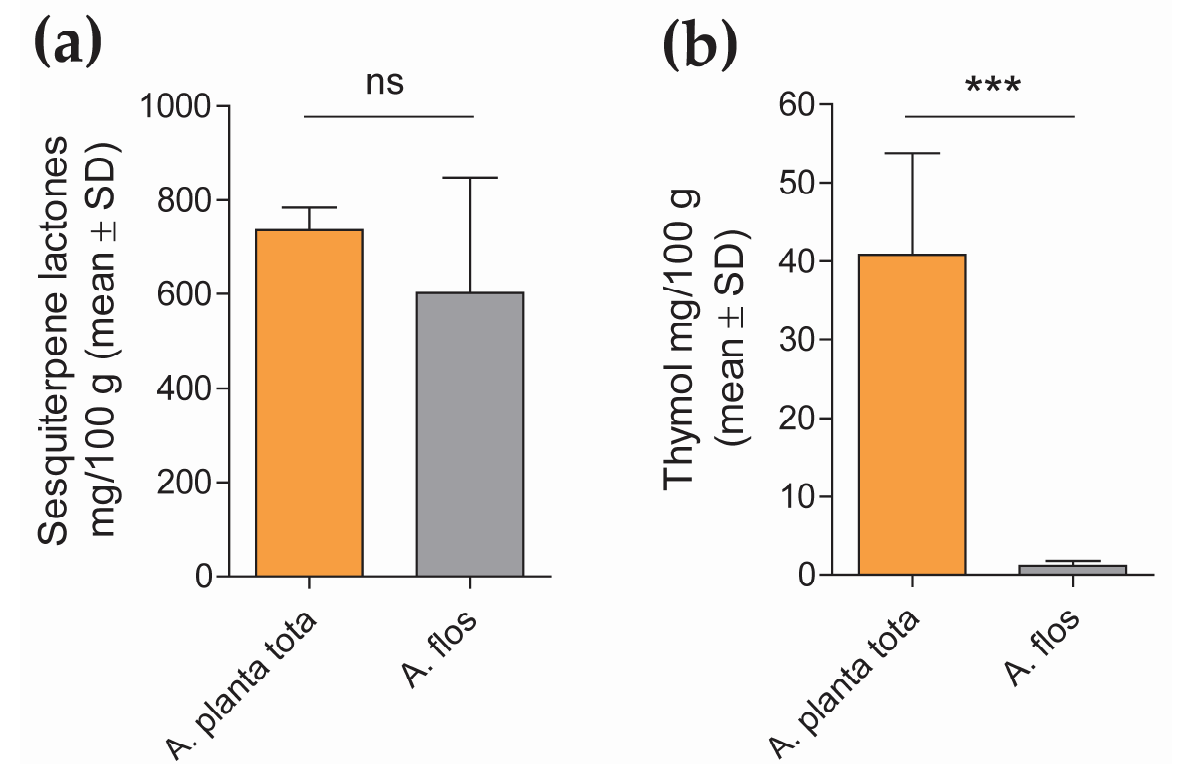
Figure 1. Sesquiterpene lactones ( a ) and thymol ( b ) content in Arnicae planta tota and Arnicae flos. Sesquiterpene lactones and thymol content was determined by HPLC from duplicate measurements of five independent extract preparations of Arnicae planta tota and Arnicae flos. Data (mean ± SD of five batch quantifications) are expressed as the amount of analyte (mg of sesquiterpene lactones or thymol) per 100 g Arnica extract. Differences in content of the measured compounds between Arnicae planta tota and Arnicae flos were compared using an unpaired t -test [ p = 0.2612 in ( a ), p = 0.0001 (***) in ( b )]. Abbreviation: A. planta tota, Arnicae planta tota; A. flos, Arnicae flos; ns,